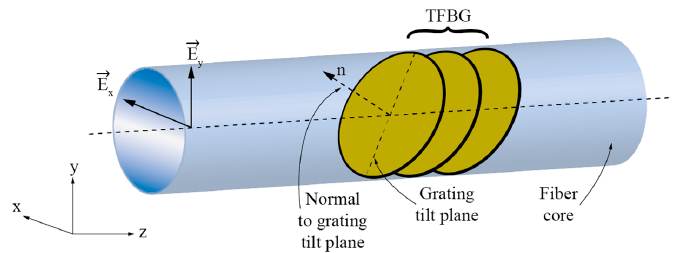
Figure 21. Each polarization state (E y and E x ) yielding to different resonant solution due to its corresponding orientation.